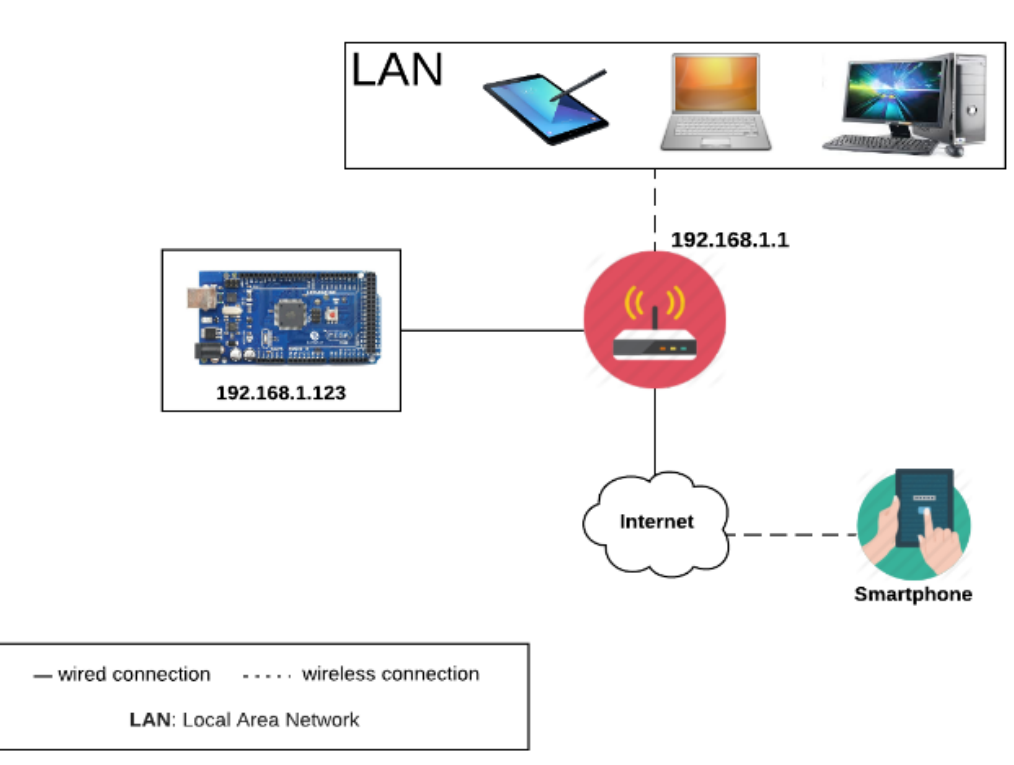
Figure 6. Home Automation System.